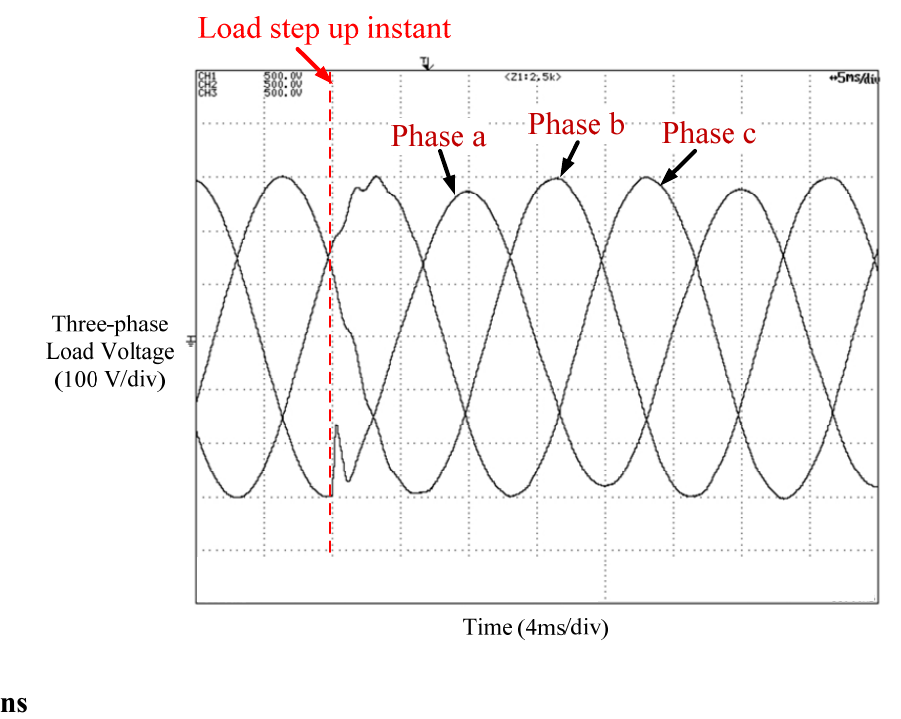
Figure 14. Experimental waveforms of three-phase load voltages (step up of single-phase resistive